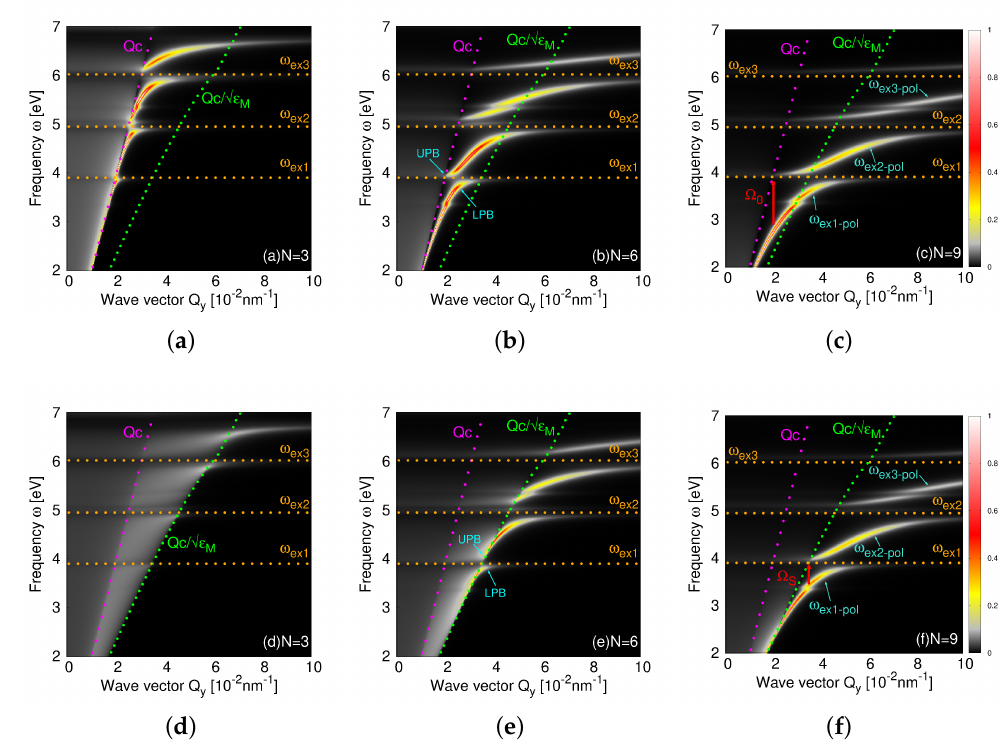
Figure 5. The spectral intensity of the s(TE)-polarized electromagnetic modes S ( Q , ω ) in the self- standing C 60 films for ( a ) N = 3, ( b ) N = 6, and ( c ) N = 9. Figures ( d – f ) show the same for